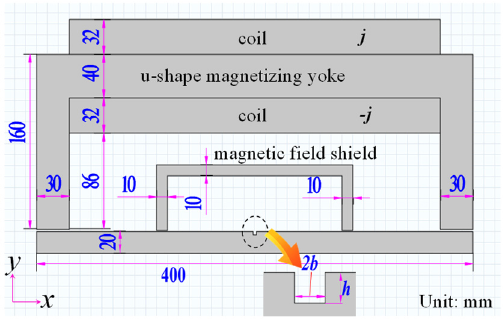
Figure 1. The FEM model.